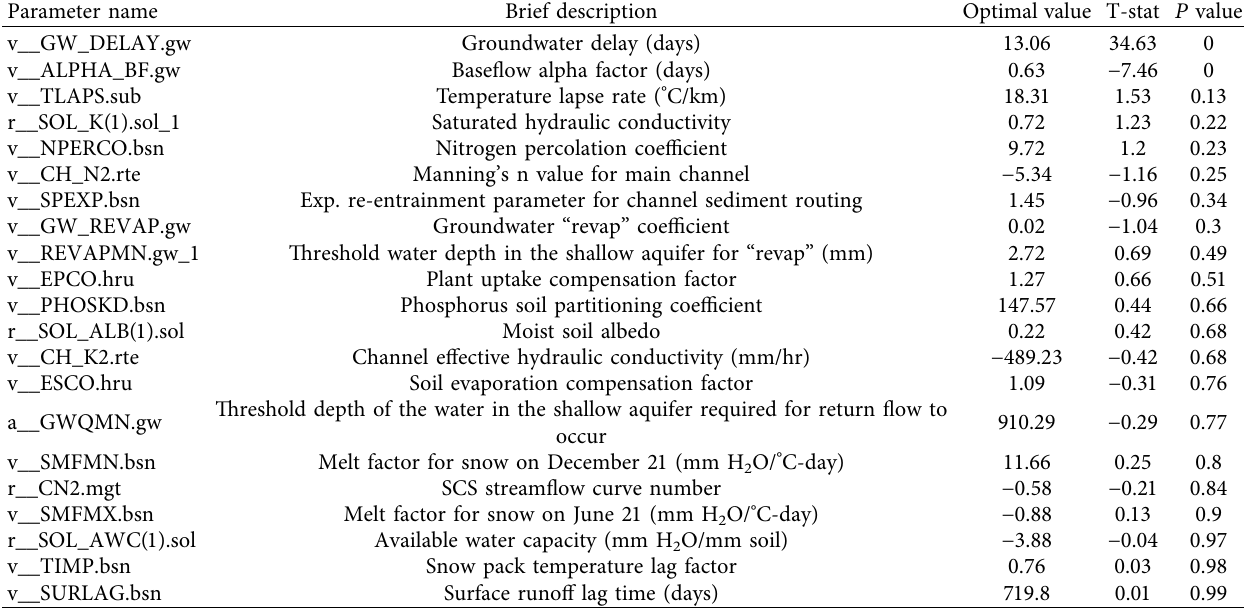
Table 7: Sensitivity ranks and optimal values of the model